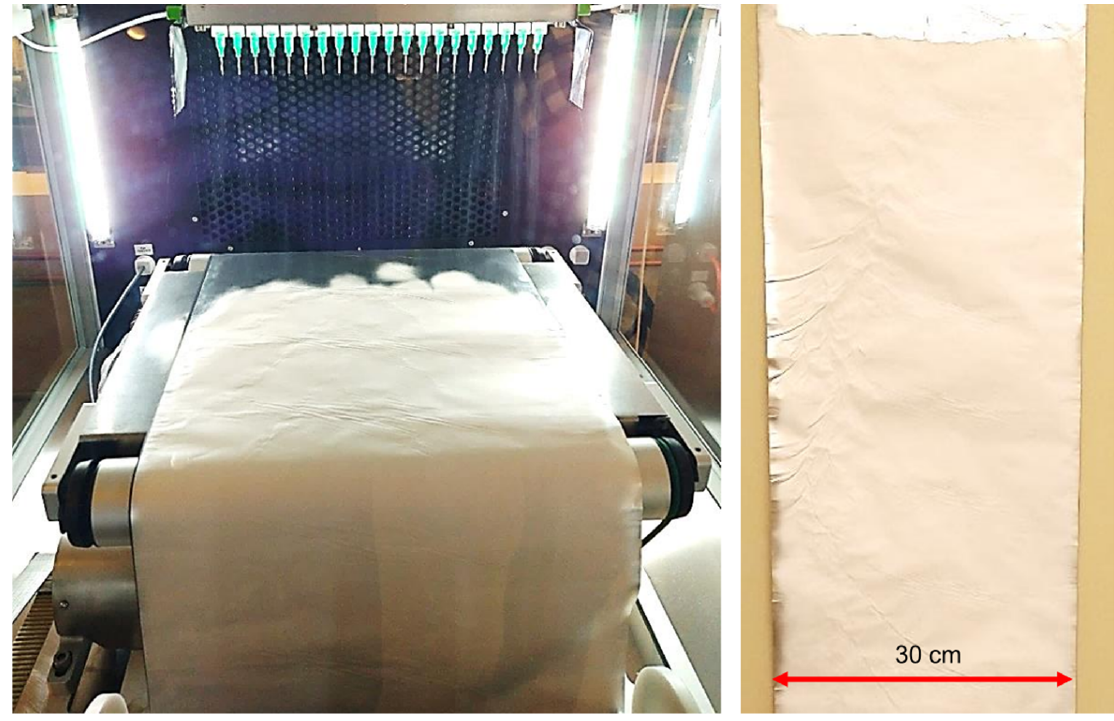
Figure 8. Production of large nonwoven membranes.